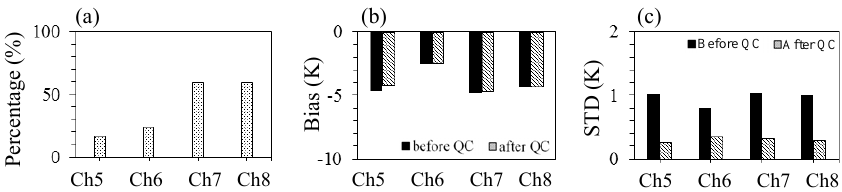
Figure 9. (a) Percentages of the MWTS-2 data that passed QC during 1–27 July 2014. (b) Global biases and (c) standard deviations of O-B before (solid bars) and after (dashed bars) quality control during 1–27 July 2014.